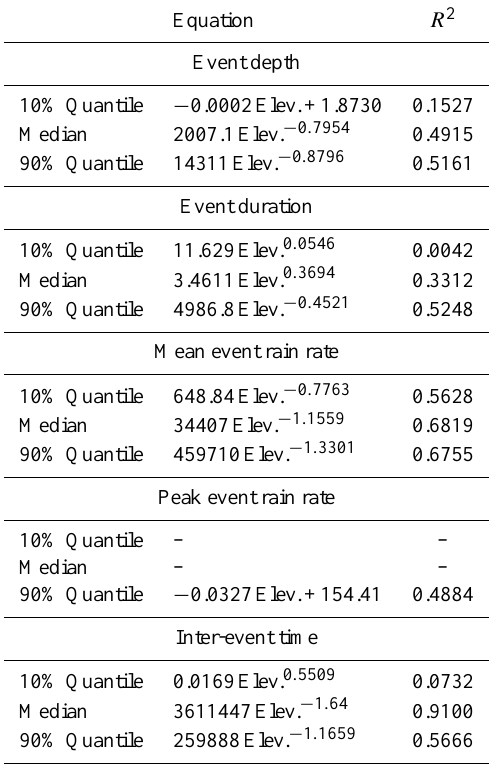
Table 4. Relation between rain event properties and terrain eleva- tion